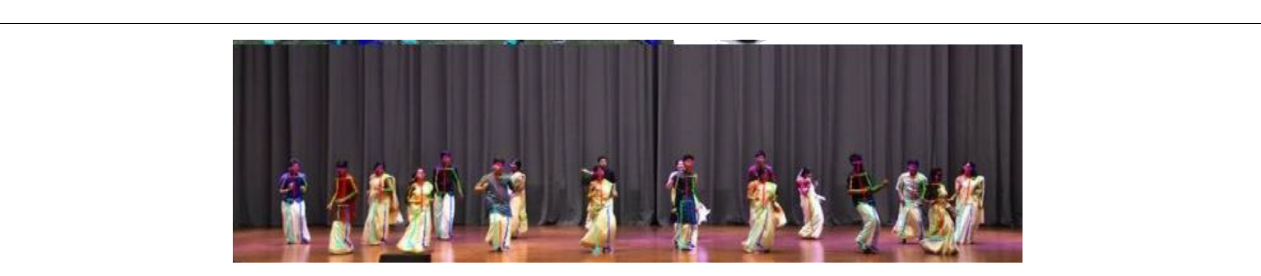
FIGURE 5 | (A) Ankle dorsi/plantarflexion measured under bright lighting of 9,800 lux. (B) Ankle dorsi/plantarflexion measured with participant in dark lighting of 50 lux. (C) Hip flex/extension measured with subject in bright lighting of 9,800 lux. (D) Hip flex/extension measured with participant in dark lighting of 50 lux. (E) Knee flex/extension measured with participant in bright lighting of 9,800 lux. (F) Knee flex/extension measured with participant in dark lighting of 50